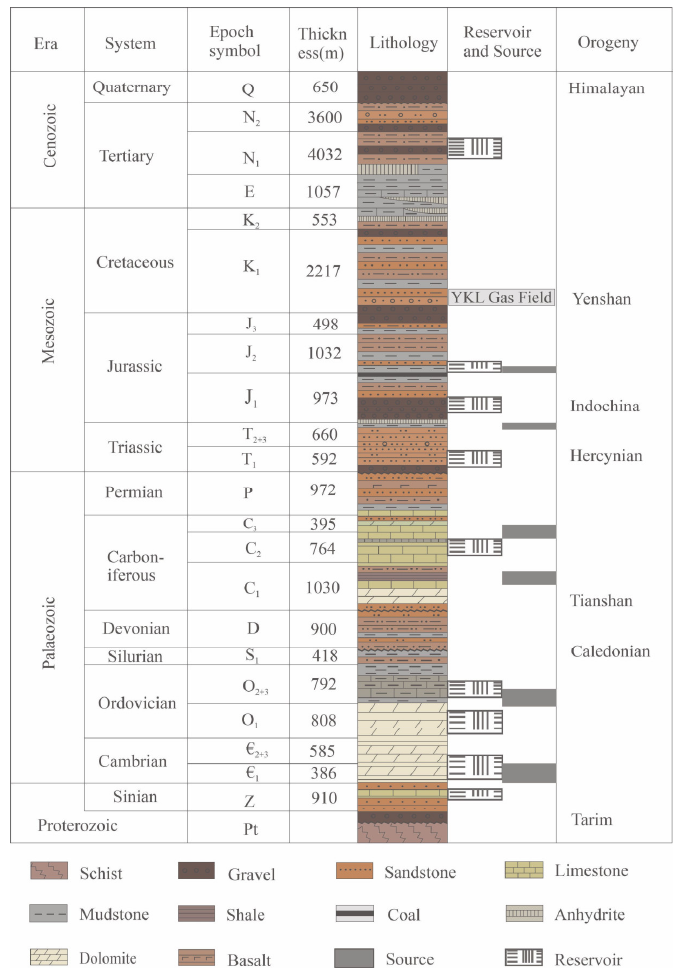
Figure 2. Generalized stratigraphic column of the Kuqa depression.